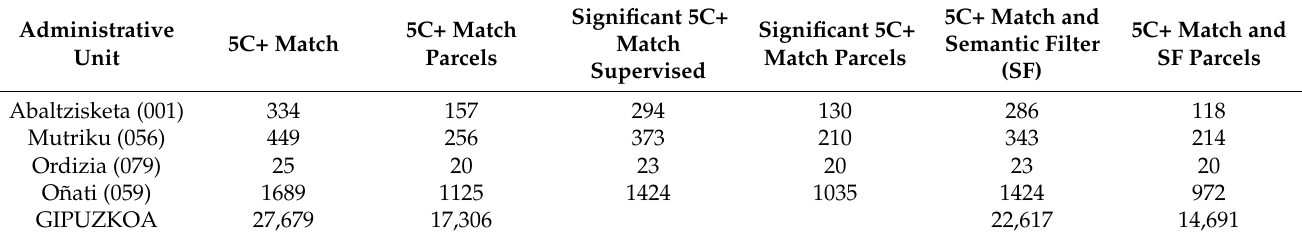
Table 3. Results obtained for strings of five or more characters; totals, with supervision and automated matching with LKB. Figures are broken down into number of matches and number of parcels.